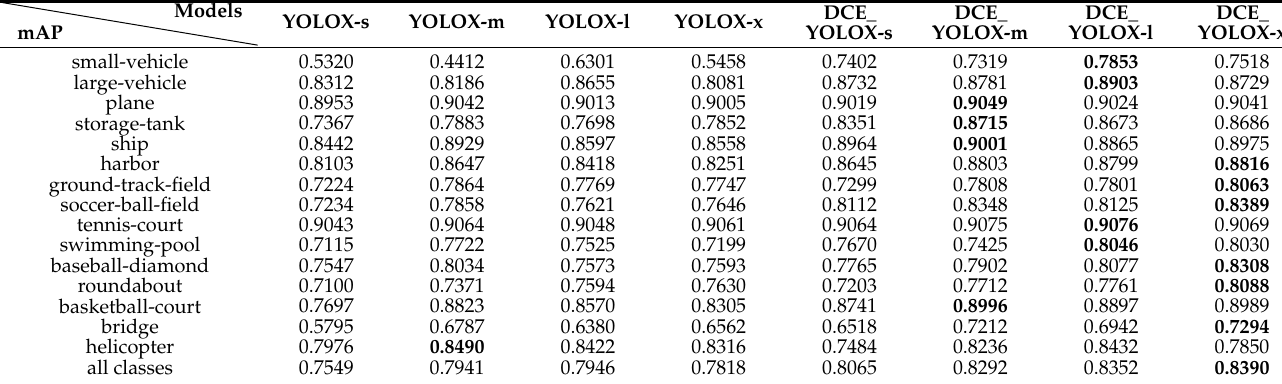
Table 2. This Detailed results of mAP for each model category.